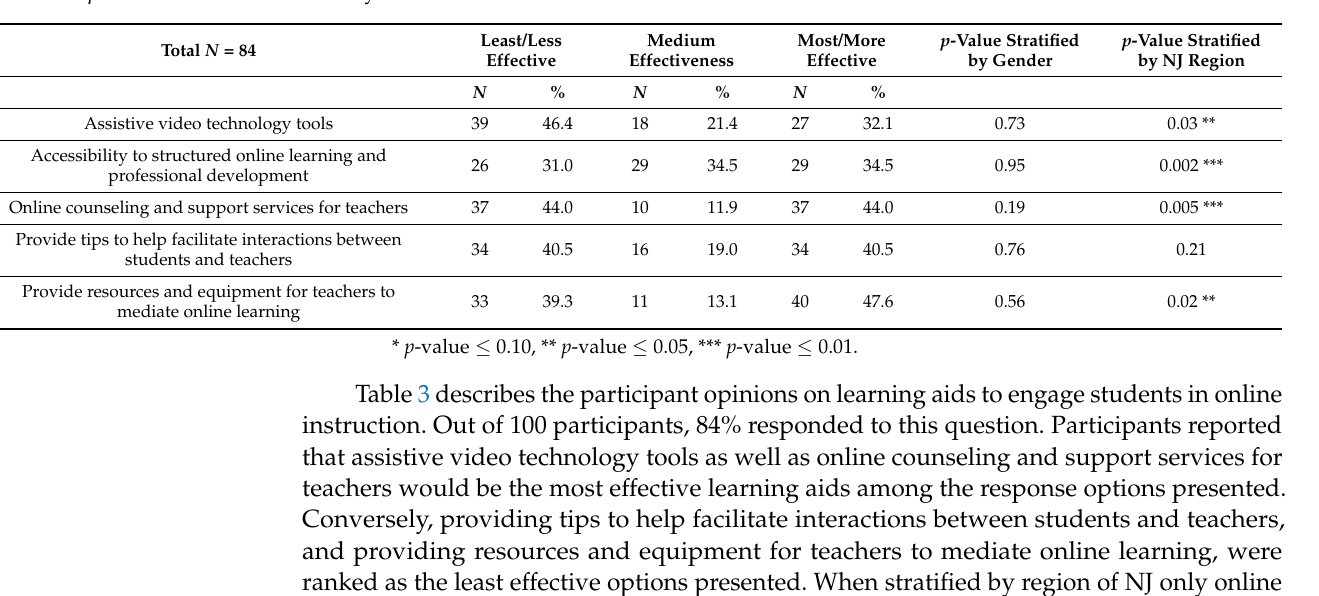
Table 2. Strategies to support teachers in facilitating remote/online instruction. Data presented for the overall study sample. Note: p -values were determined by Fisher’s exact test. Total N = 84 Least/Less Effective Medium Effectiveness Most/More Effective N % N % N %